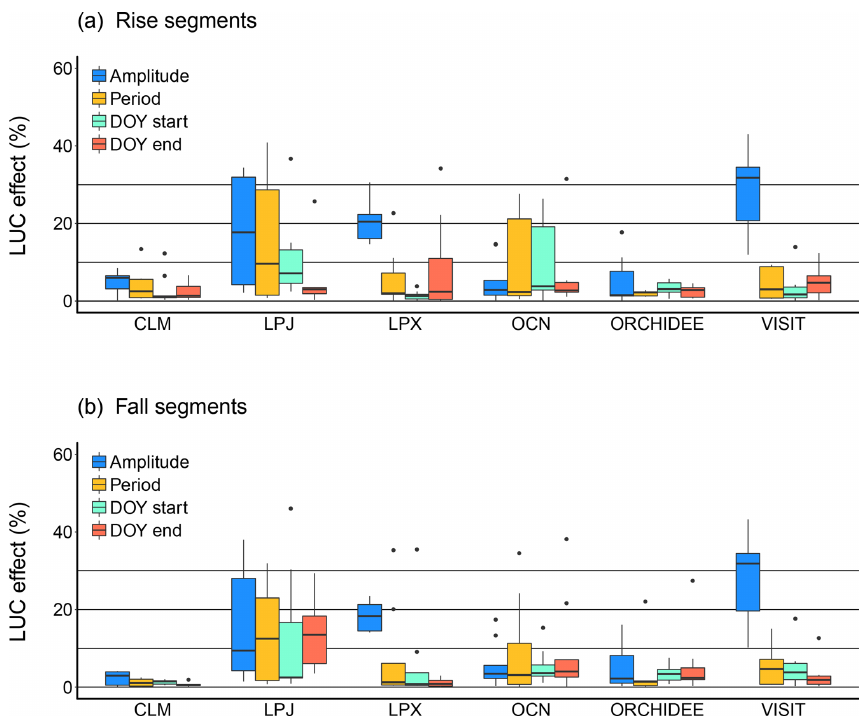
Figure 8. Land use change effect on amplitude, period and day of year (DOY). The percentages were calculated from the difference in the metrics between simulations (S3–S2), scaled relative to amplitude and period of rise and fall segments for each region and model. DOY was scaled against the